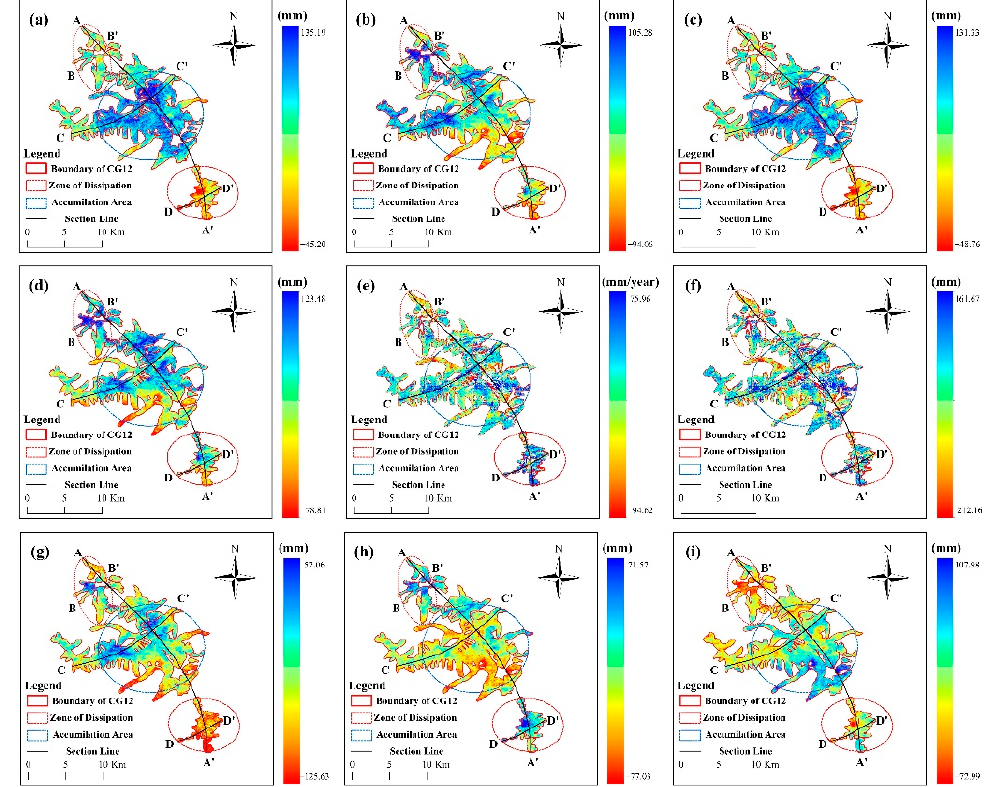
Figure 9. Meili Mountain glacier accumulation and ablation zone deformation variables (“AA’” is the vertical section of the mountain glacier, ”BB’”, “CC’” and “DD’” are transects of the glacier accumulation and ablation zone, respectively.), ( a ) ascending orbit DInSAR results, ( b ) descending orbit DInSAR deformation results, ( c ) ascending orbit MAI results, ( d ) descending orbit MAI results, ( e ) SBAS-InSAR deformation rates, ( f ) SBAS-InSAR deformation variables, ( g ) 3D deformation vertical results, ( h ) 3D deformation north–south results, ( i ) 3D deformation east–west results.